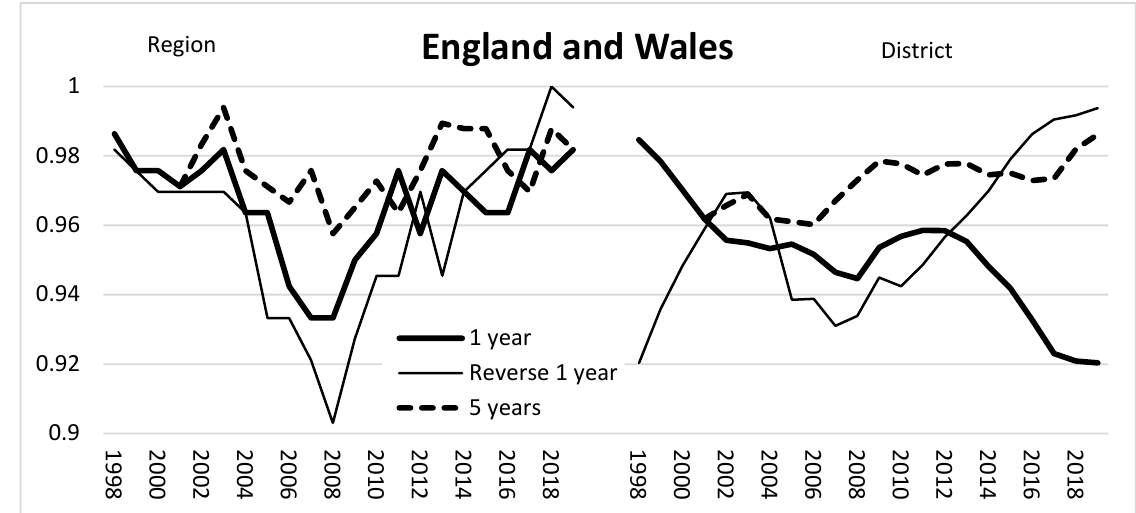
Figure 2. Kendall’s Concordance.